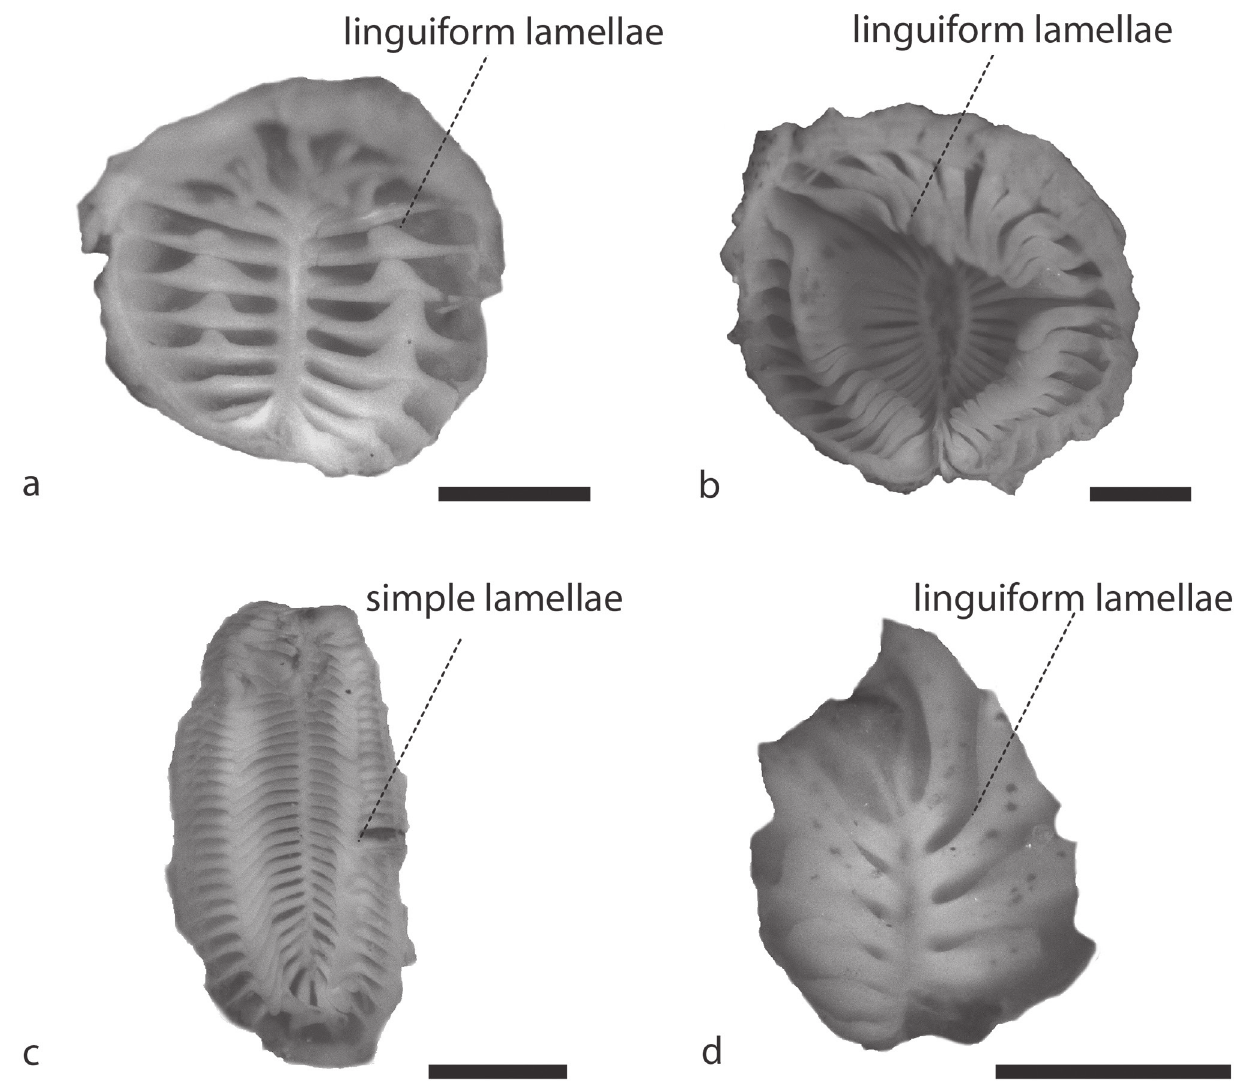
Fig. 6. Olfactory epithelium of representatives of Otophysi. a. Cyprinus carpio (Cypriniformes); b. Brycon orbignyanus (Characiformes); c. Pimelodus maculatus (Siluriformes) and; Sternopygus macrurus (Gymnotiformes). Scale bars = 1